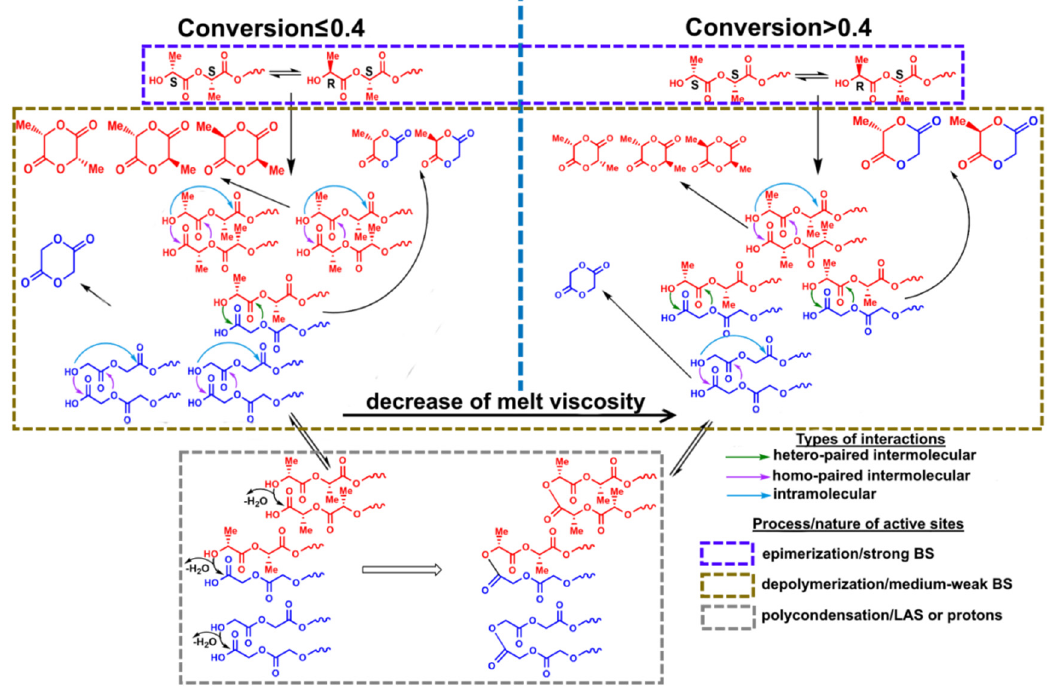
Figure 12. Detailed scheme of depolymerization for an example of GAO:LAO mixture.